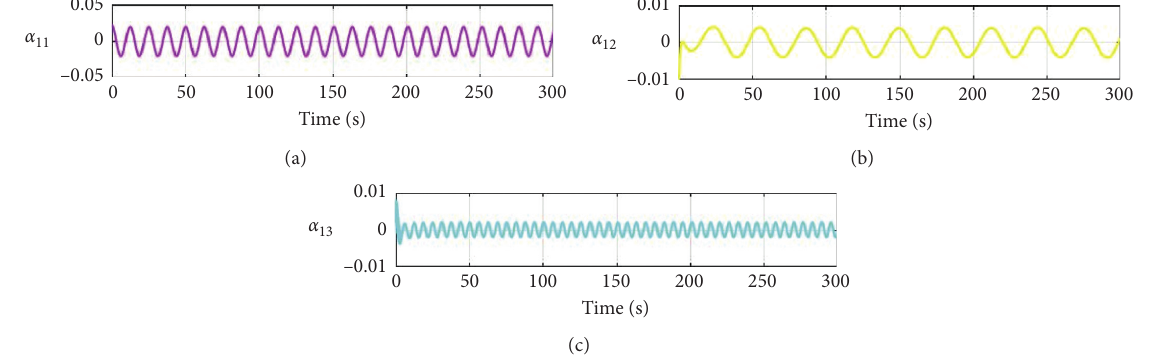
, α , and α 11 12 13